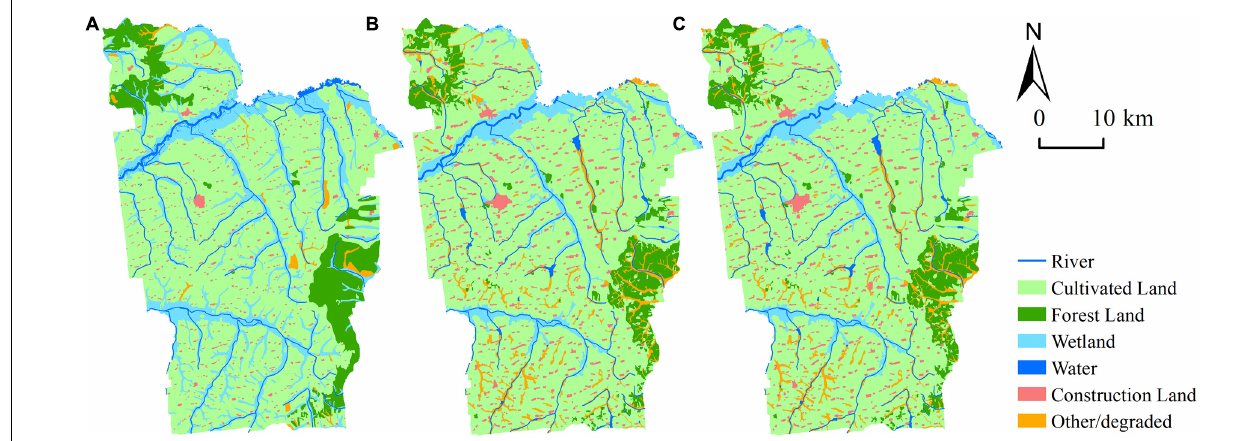
FIGURE 6 | Land use in (A) 1965, (B) 2005, and (C) 2015.